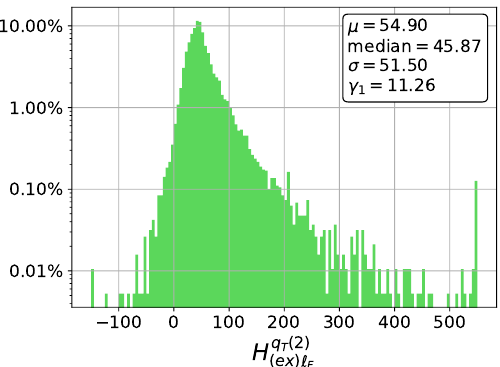
Figure 4. Distribution of the values of the two-loop hard function computed using the interpolator without rescue system for the (cid:22) uu channel. In the legend the mean ( (cid:22) ), the median, the standard deviation ( (cid:27) ) and the skewness ( (cid:13) 1 ) are reported. The edge bins account for